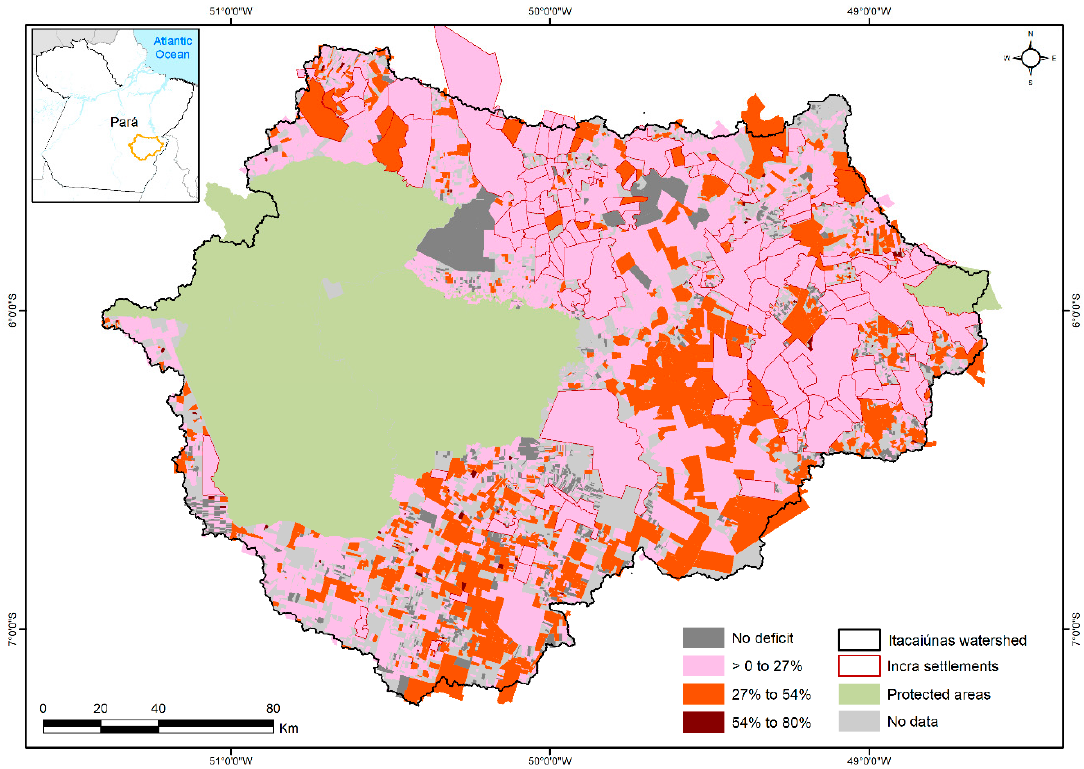
Figure 5. Distribution of the total legal reserve deficit (forest cover under the required RL: deficit to be compensated + deficit to be restored) in rural properties registered under CAR and in Incra settlements, as defined by Brazilian environmental law (Law no. 12651, 25 March 2012), across the Itacaiúnas watershed. Percentages are related to the deficit area in relation to the property size.